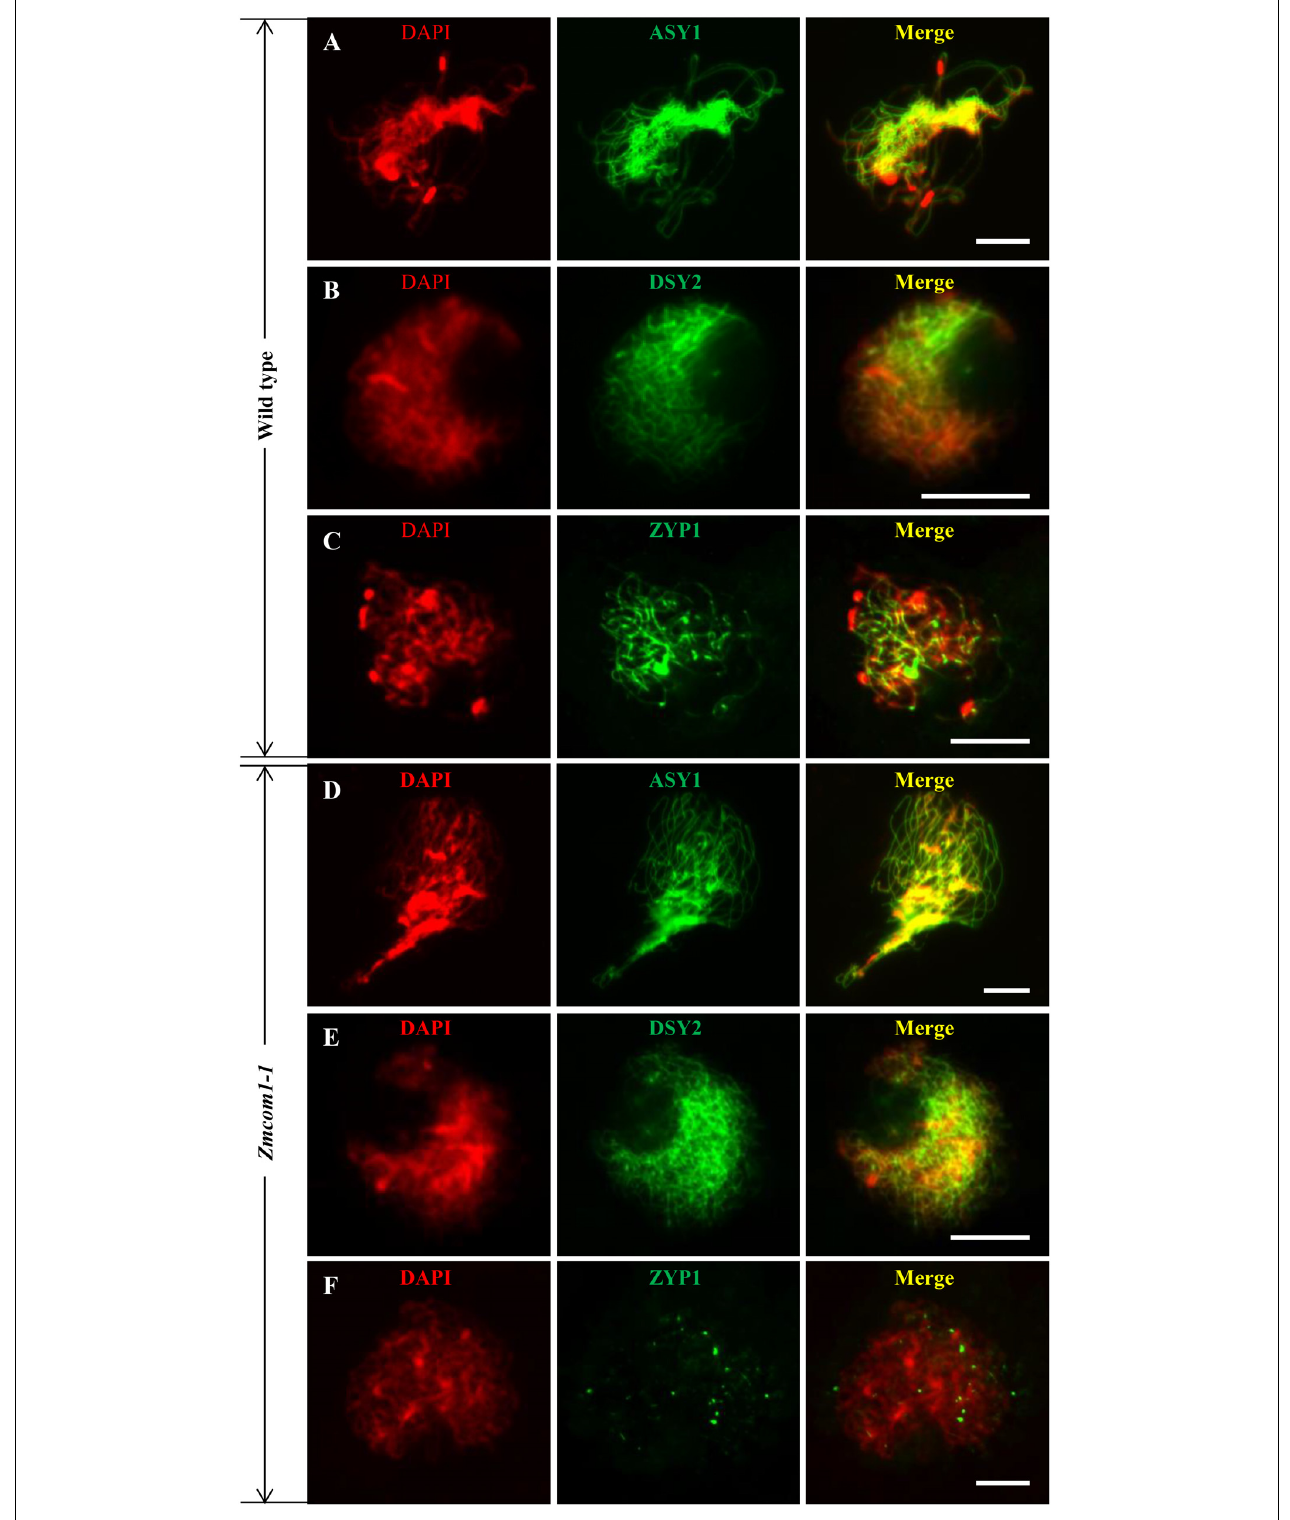
FIGURE 5 | Immunolocalization of ASY1, DSY2, and ZYP1 antibodies in the wild type and Zmcom1-1 . (A–C) ASY1 (A) , DSY2 (B) , and ZYP1 (C) on prophase I chromosomes in the wild type. DAPI staining is used to indicate the chromosomes. Scale bars = 10 µ m. (D–F) ASY1 (D) , DSY2 (E) , and ZYP1 (F) on prophase I chromosomes in Zmcom1-1 . Scale bars = 10 µ